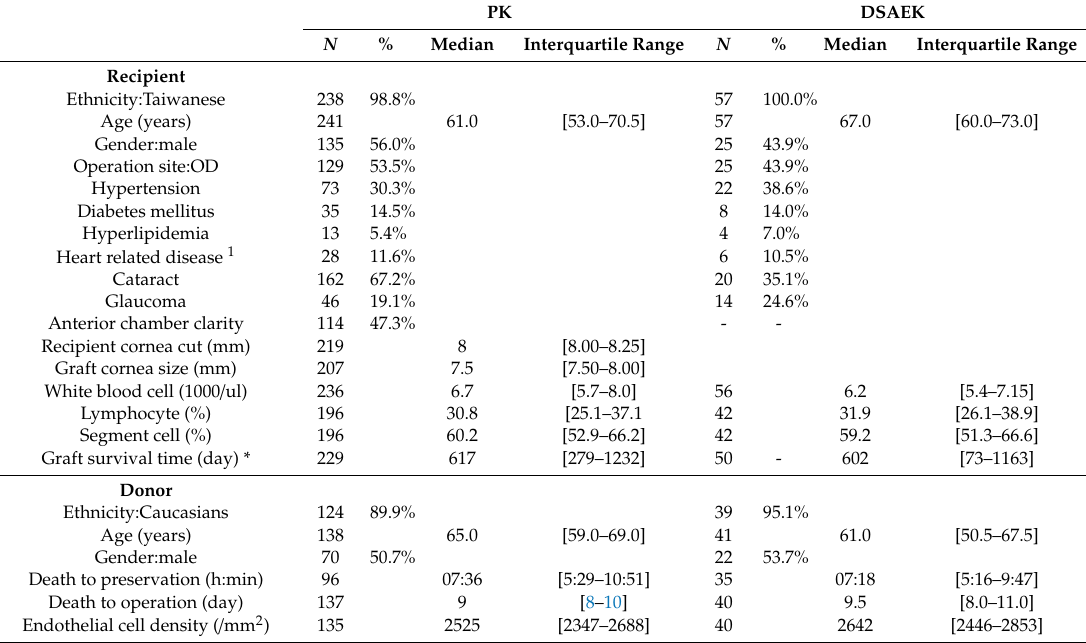
Table 2. Summary of recipients and donors’